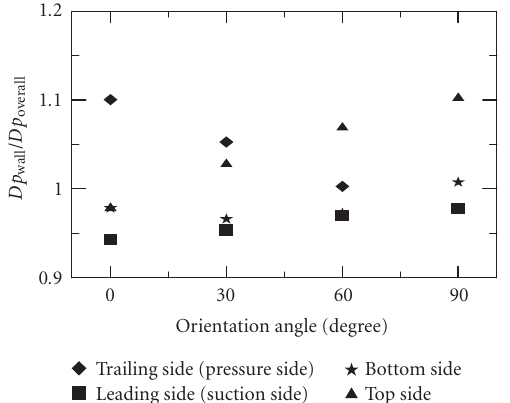
Figure 14: Variation of pressure drop on individual wall as a frac- tion of overall pressure drop for two-wall detached ribbed square channel at Re = 17000 and Ro = 0 .